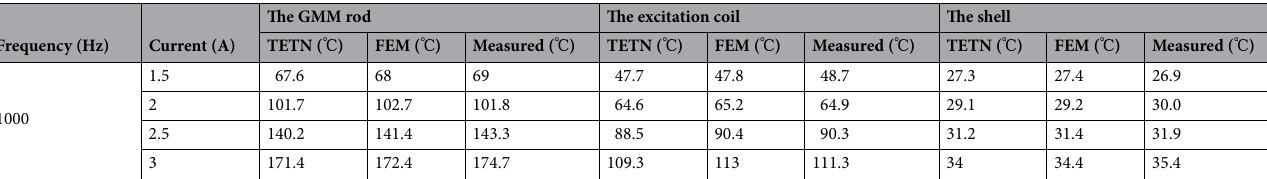
Table 6. Comparison of calculated and measured final temperatures at various locations.